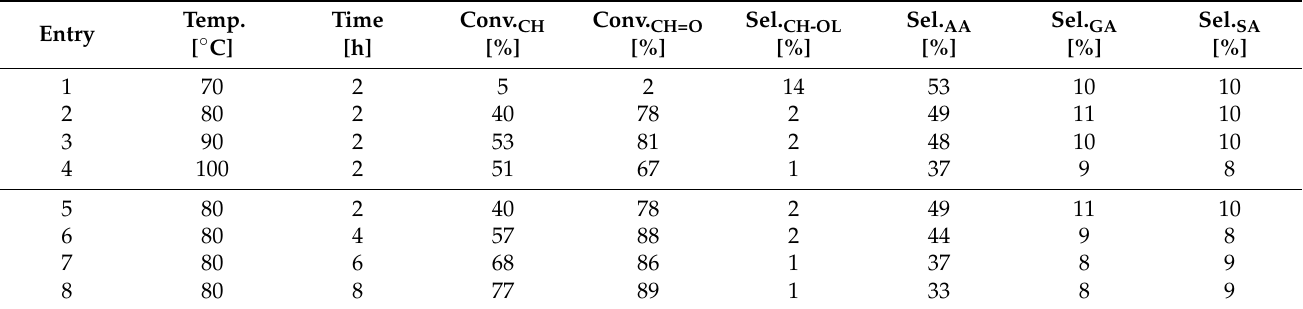
Table 4. The influence of temperature and time on CH/CH=O mixture oxidation.